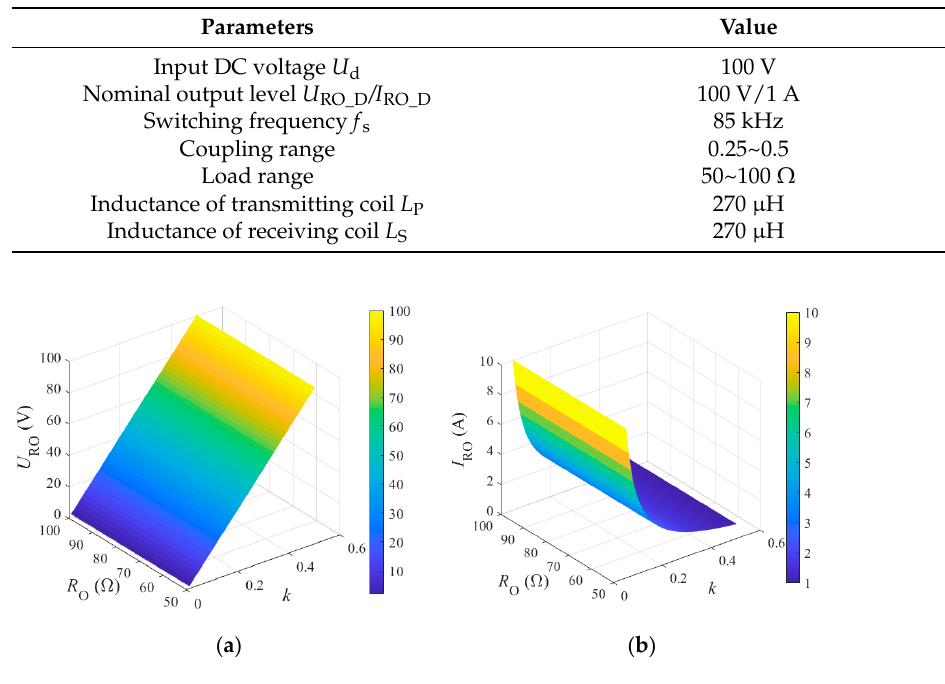
Figure 3. The power transfer properties of LCC-S topology under misalignment: ( a ) the results of CVO-type topology ; ( b ) the results of CCO-type topology.